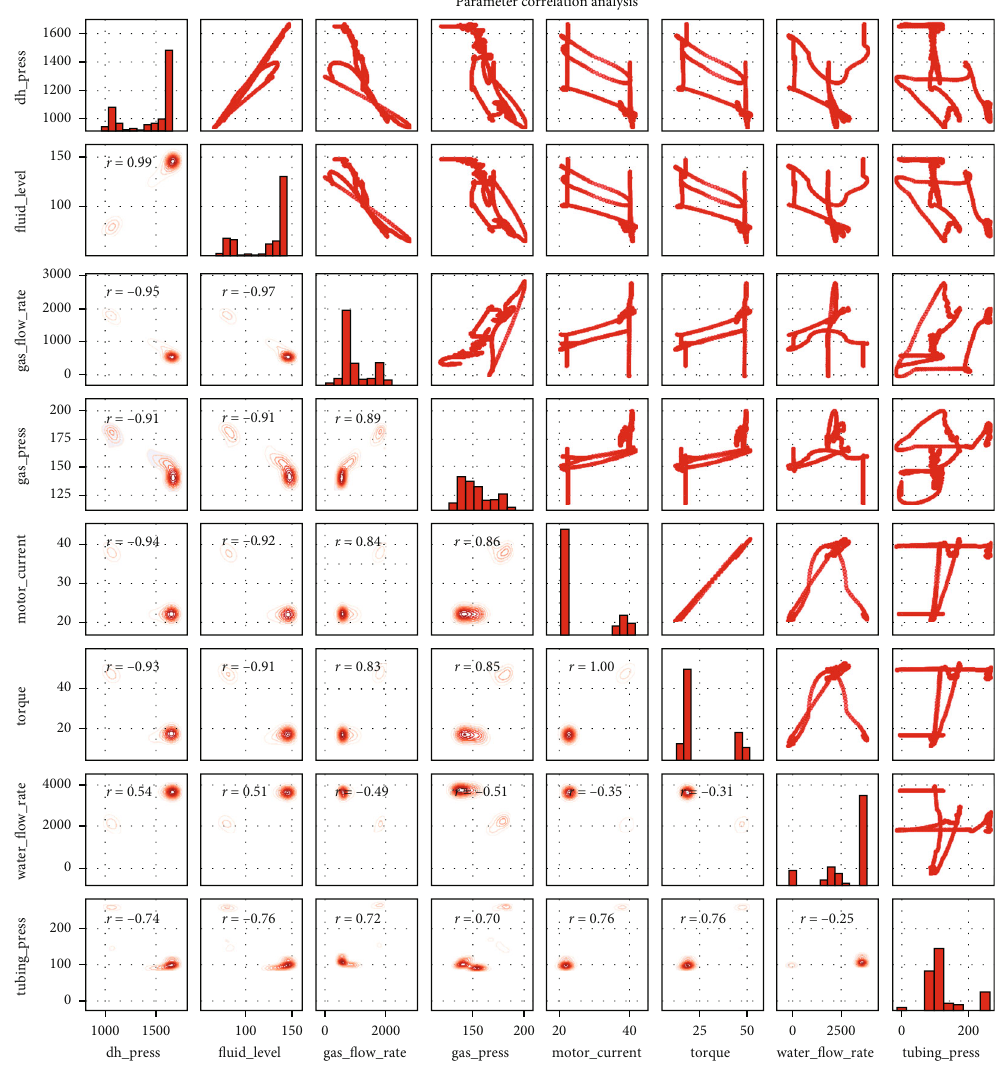
Figure 3: Parameter correlation distribution graph.